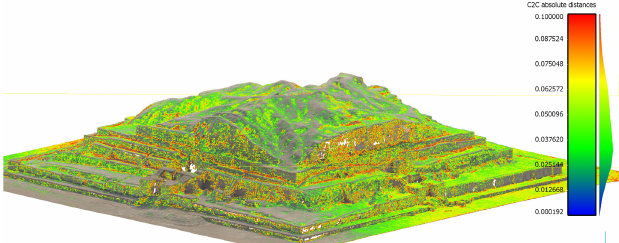
Figure 13. C2C distance comparison between NUAV and HAOUAV clouds.